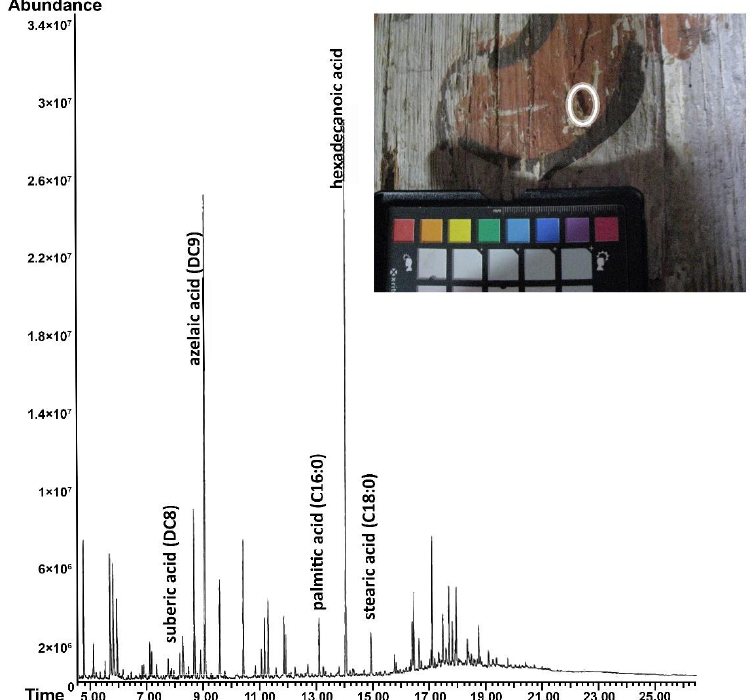
Figure 9. An example of the total ion chromatogram for wooden specimen and image of sample location. Total ion chromatogram of wood specimen (Hl1d) showing characteristic peaks of pine resin around 16–19 minutes (i.e., abietic acid). Circle within image denotes sample location.